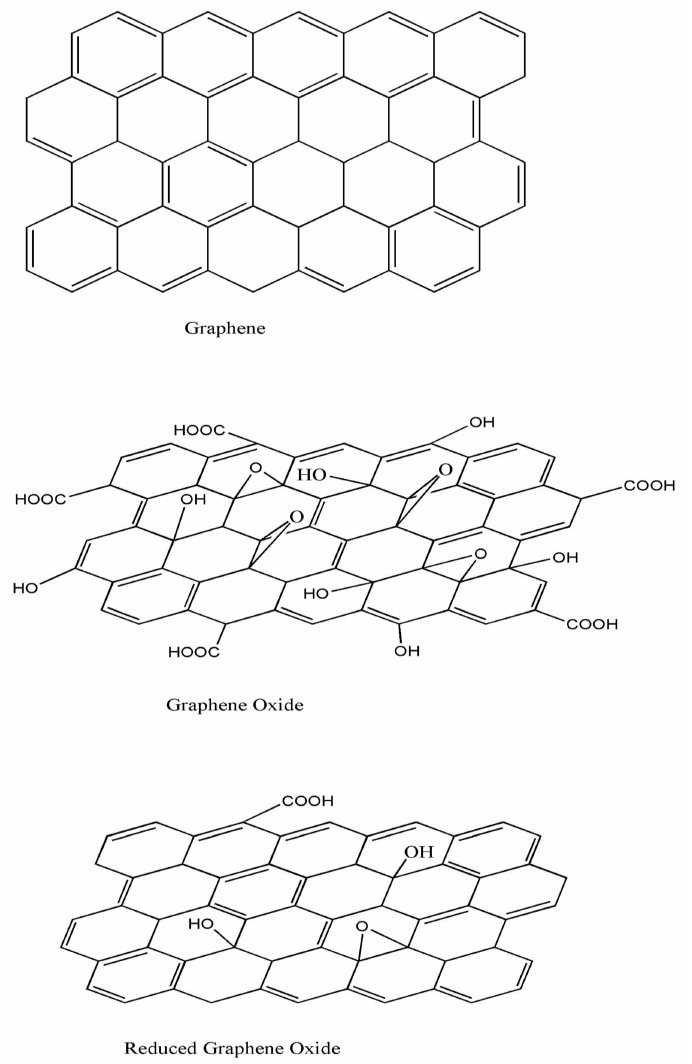
Figure 1. Schematic illustration of the chemical structure of graphene (G) and its derivatives, graphene oxide (GO) and reduced graphene oxide